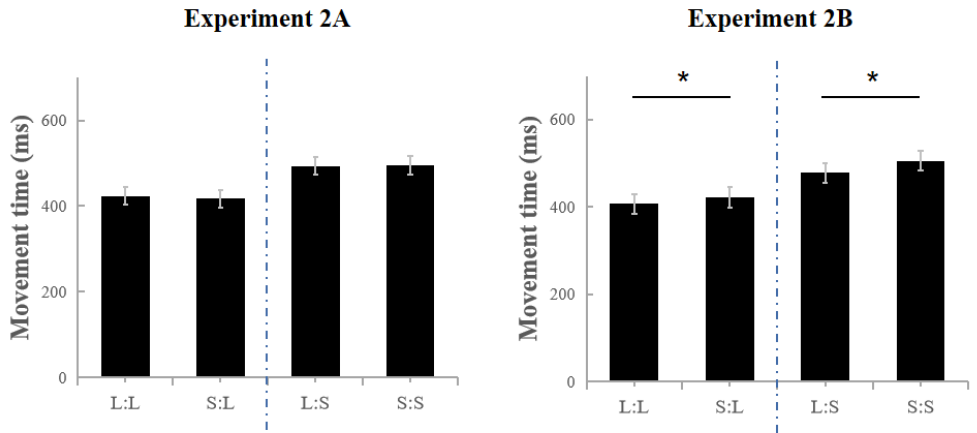
Figure 6. Results of Experiment 2A (Exp2A) and Experiment 2B (Exp2B). In Exp2A, no significant